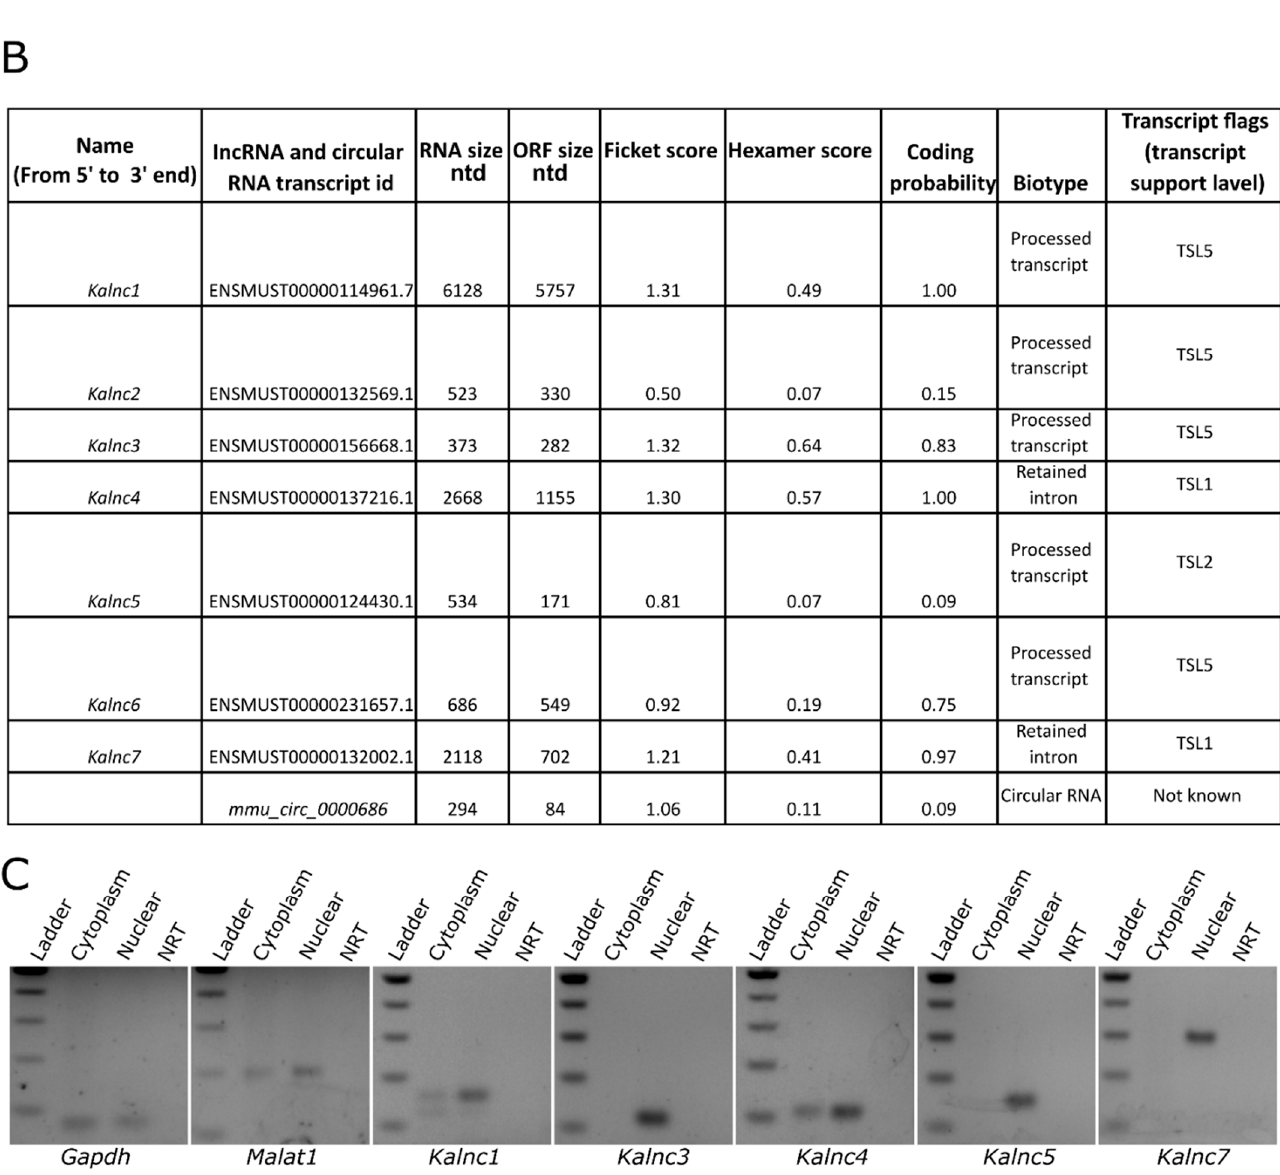
Figure 1. Schematic illustration and coding potential prediction of mouse Kalrn gene locus noncoding transcripts. ( A ) A schematic illustration of mouse Kalrn long noncoding transcripts (lncRNAs) was made according to the Ensembl database; blue: coding transcripts, green: processed transcripts, red: retained introns, black: circular RNA. Noncoding (NC) transcripts were named in the 5 (cid:48) end (corresponding to the quantitatively major 5 (cid:48) end called ‘C’) to 3 (cid:48) end direction from Kalnc1 to Kalnc7 . ( B ) Coding potential was measured by CPAT software [26]. Transcript flags, or transcript support level (TSL), are a method to highlight the well-supported and poorly-supported transcript models. The method relies on the primary data that can support full-length transcript structure: mRNA and EST alignment supplied by UCSC and Ensembl. TSL1—all splice junctions of the transcript are supported by at least one non-suspect mRNA. TSL2—the best supporting mRNA is flagged as the suspect, or the support is from multiple ESTs; TSL3—the only support is from a single EST; TSL4—the best supporting EST is flagged as the suspect; and TSL5—no single transcript supports the model structure. ( C ) Nuclear/cytoplasmic localization of Kalnc1 , 3 , 4 , 6 and 7 . NRT; “No reverse transcriptase” control to rule out trace DNA